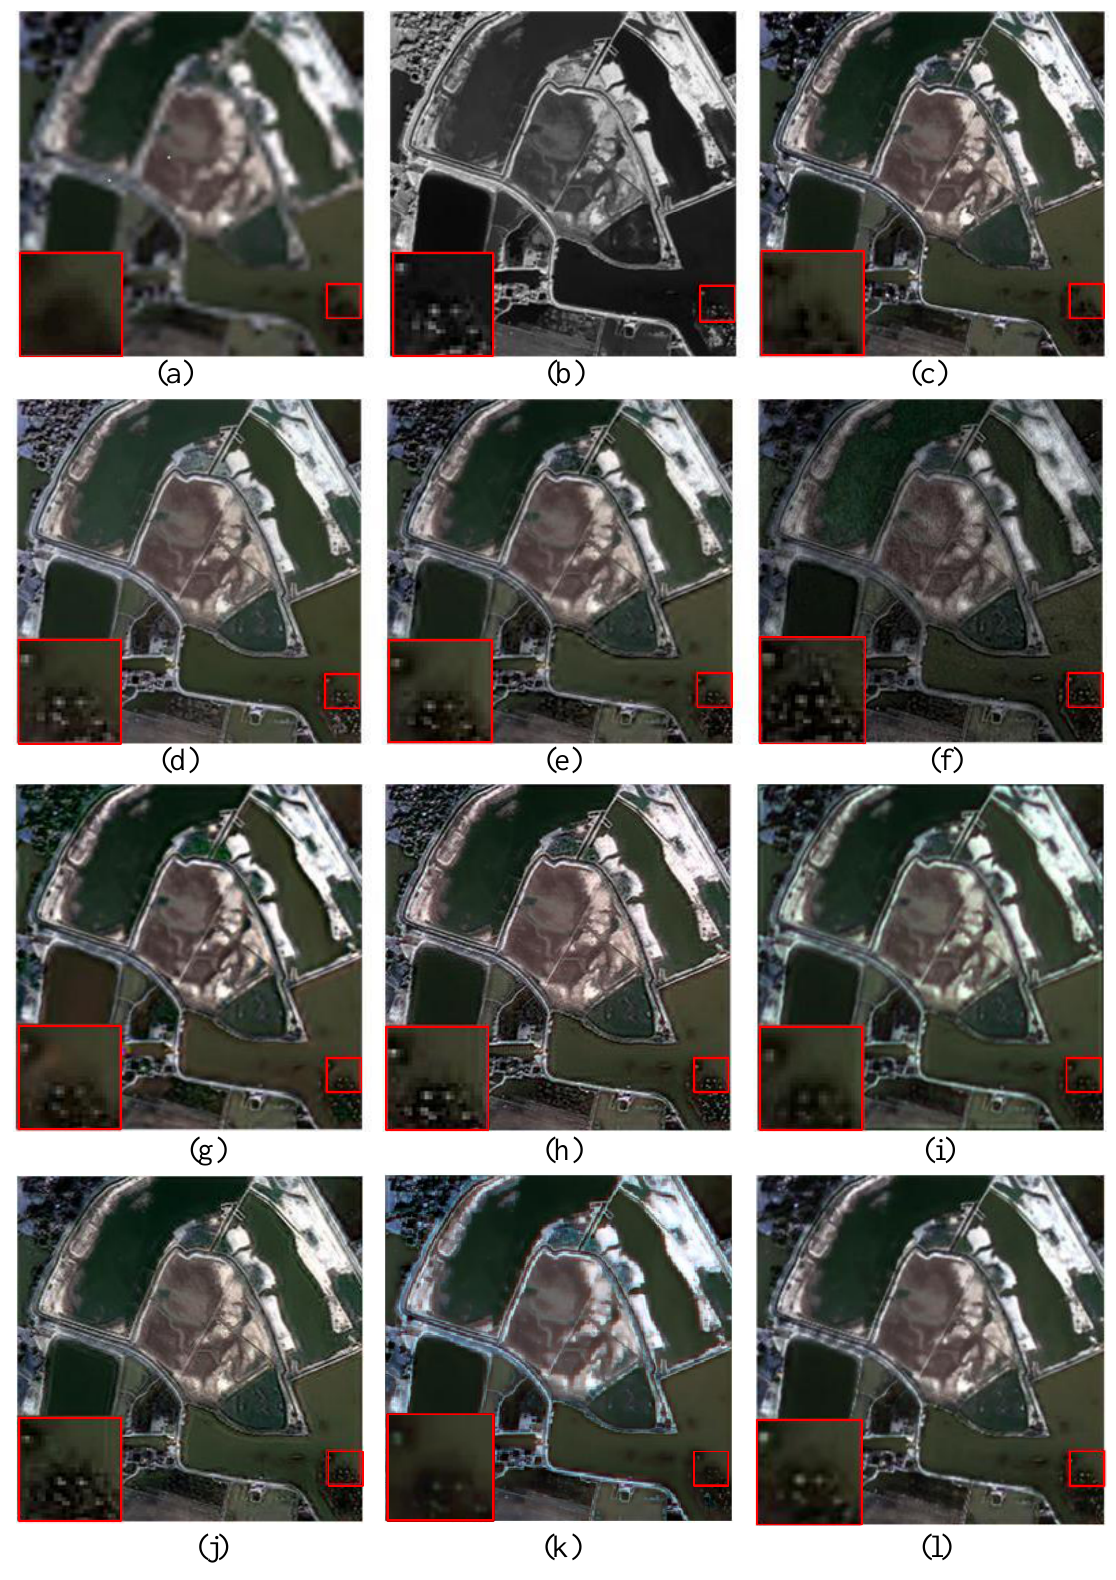
Figure 10. The fused results on the simulated QuickBird dataset. ( a ) LR-MS. ( b ) PAN. ( c ) The ground truth. ( d ) GS. ( e ) Indusion. ( f ) SR. ( g ) PNN. ( h ) PanNet. ( i ) MSDCNN. ( j ) MIPSM. ( k ) GTP-PNet. ( l )